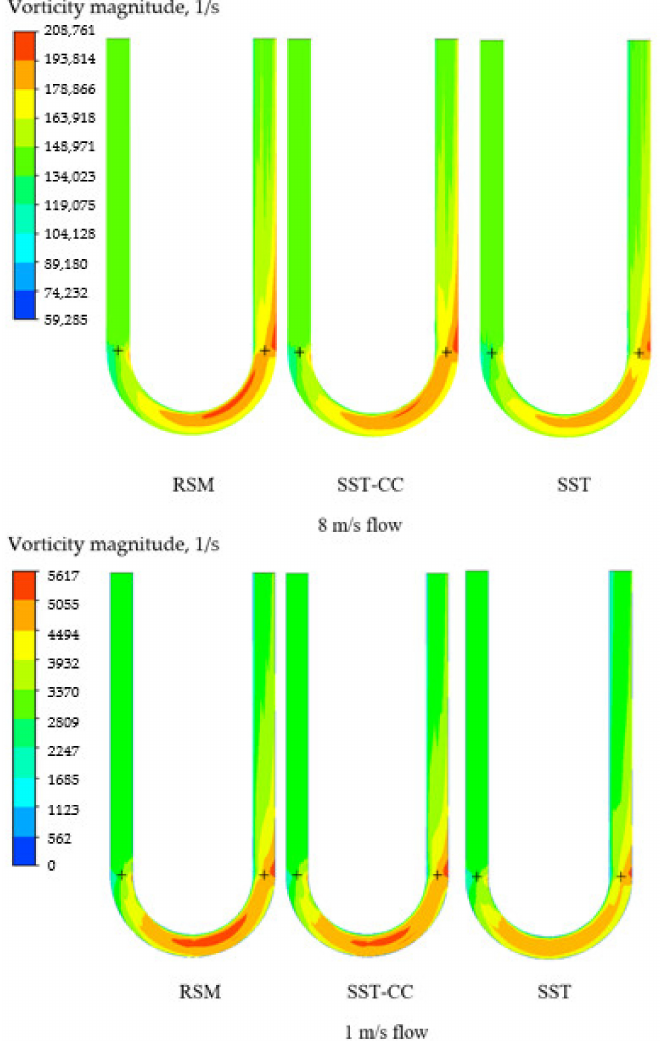
Figure 10. Vorticity magnitude values for the shear stress (SST) and Reynolds stress (RSM) turbulence models at different flow